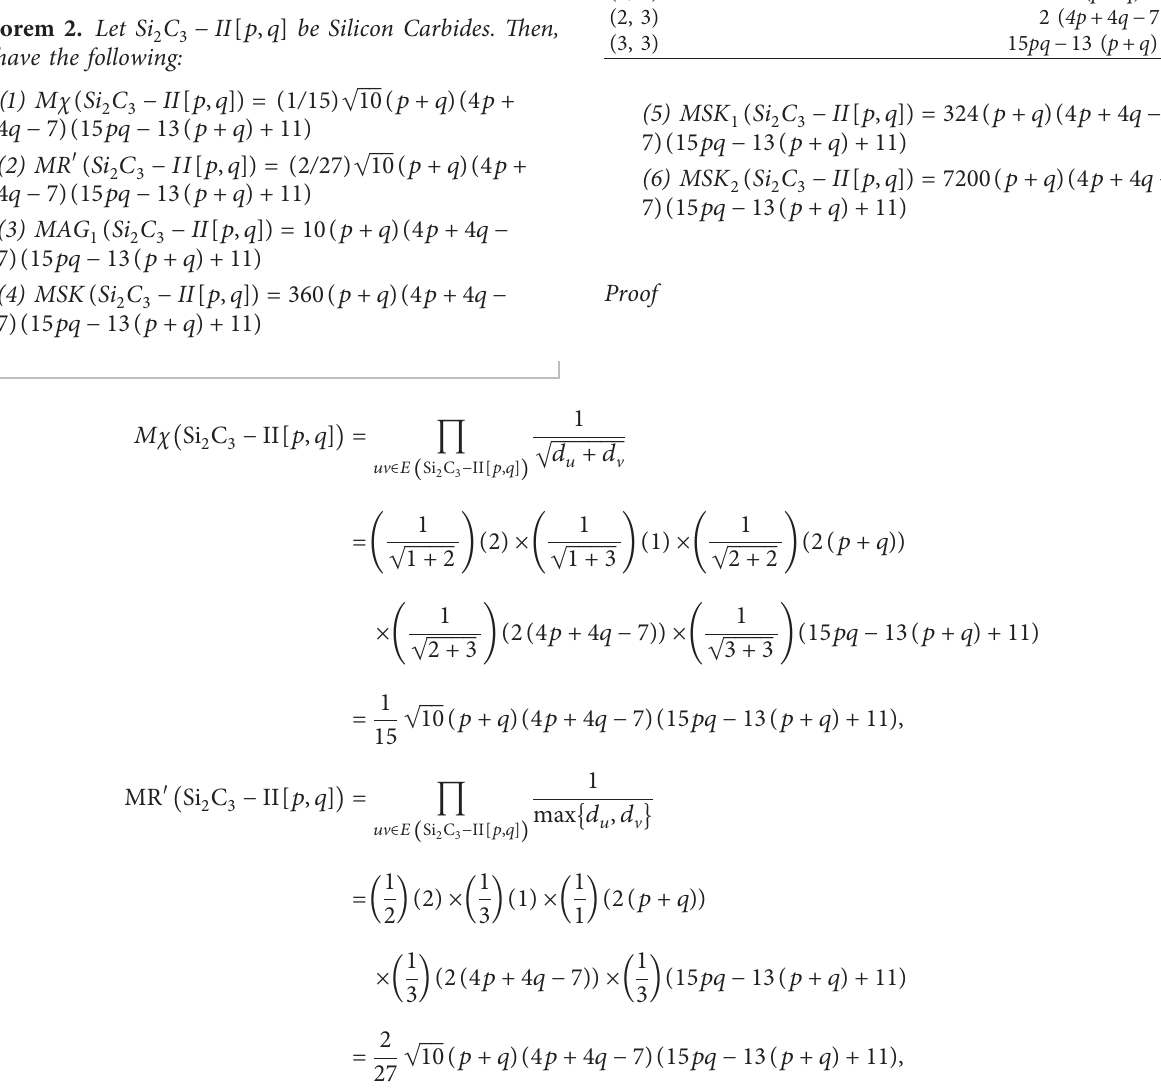
− II [ 5 , 2 ] . C 2 3 − II [ p,q ]) C 2 3